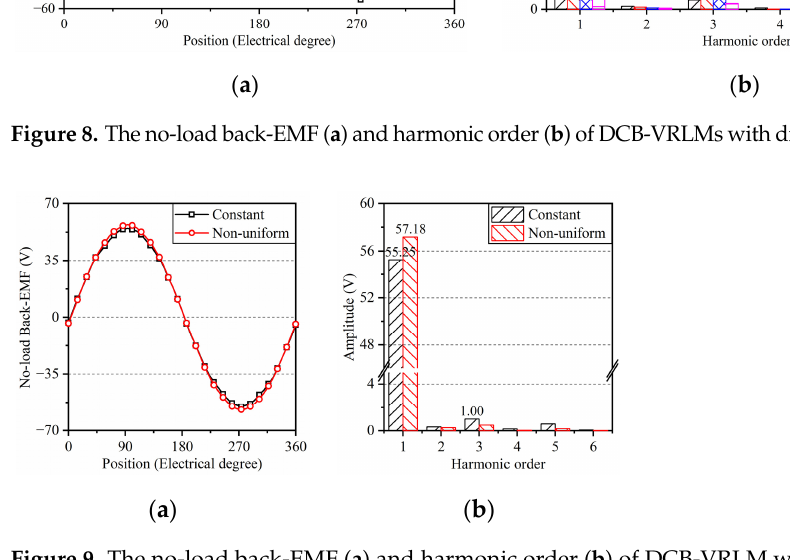
Figure 9. The no ‐ load back ‐ EMF ( a ) and harmonic order ( b ) of DCB ‐ VRLM with the constant and Figure 9. The no-load back-EMF ( a ) and harmonic order ( b ) of DCB-VRLM with the constant and non ‐ uniform air gap. non-uniform air gap.